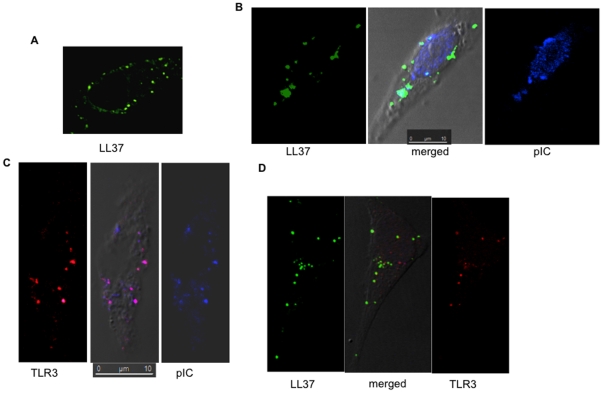
LL37 co-localizes with TLR3 and poly(I:C).A) The location of LL37 in BEAS2B cells. BEAS2B cells were cultured on coverslips and FAM-LL37 was added at a final concentration of 2 µM. Five hours after the addition of FAM-LL37, the cells were fixed and examined using confocal microscopy. B) LL37 can co-localize with Cy5-poly(I:C). FAM-LL37 (2 µM) and Cy5-poly(I:C) (1 µg/ml) were added to BEAS2B cells. The cells were fixed and imaged 5 h after the addition of the fluorescently-tagged molecules. C) TLR3 can co-localize with poly(I:C) independent of exogenously-provided LL37. BEAS2B cells were treated with Cy5-poly(I:C), then permeabilized and stained with a goat anti-TLR3 antibody in complex with Texas Red-labeled secondary antibody. D) Co-localization of FAM-LL37, endogenous TLR3 and Cy5-poly(I:C). The scale bar is 10 microns.